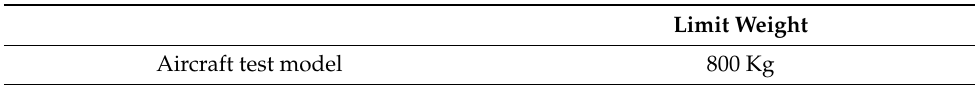
Table 4. Limit weight of aircraft test model permitted by